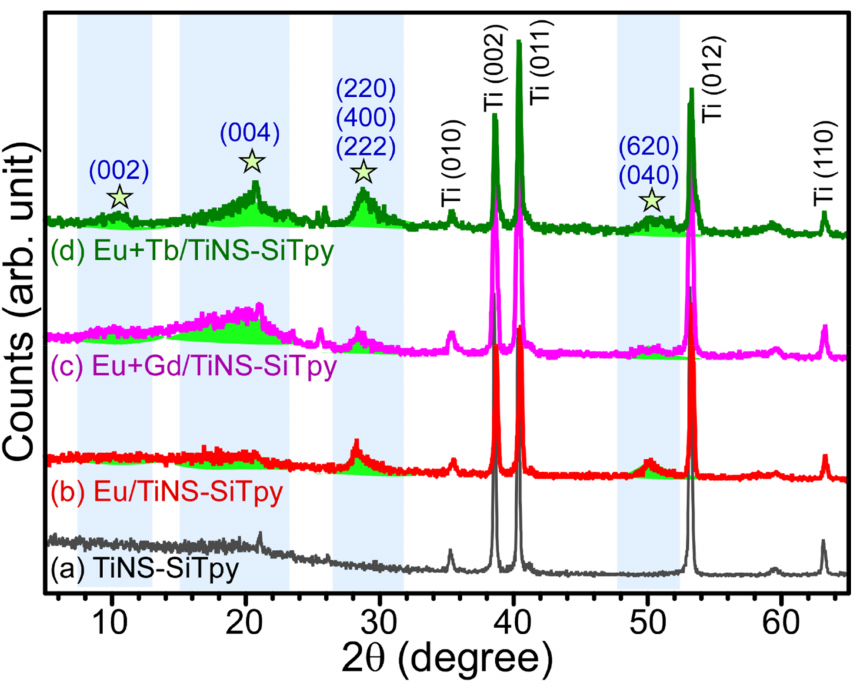
Figure 5. XRD (X-ray diffraction) profiles for bare ( a , gray line), electrodeposited Eu ( b , red line), Eu + Gd ( c , pink line), and Eu + Tb ( d , green line) on TiNS-SiTpy electrodes. Green shaded areas and star symbol indicate the major XRD peak positions of the